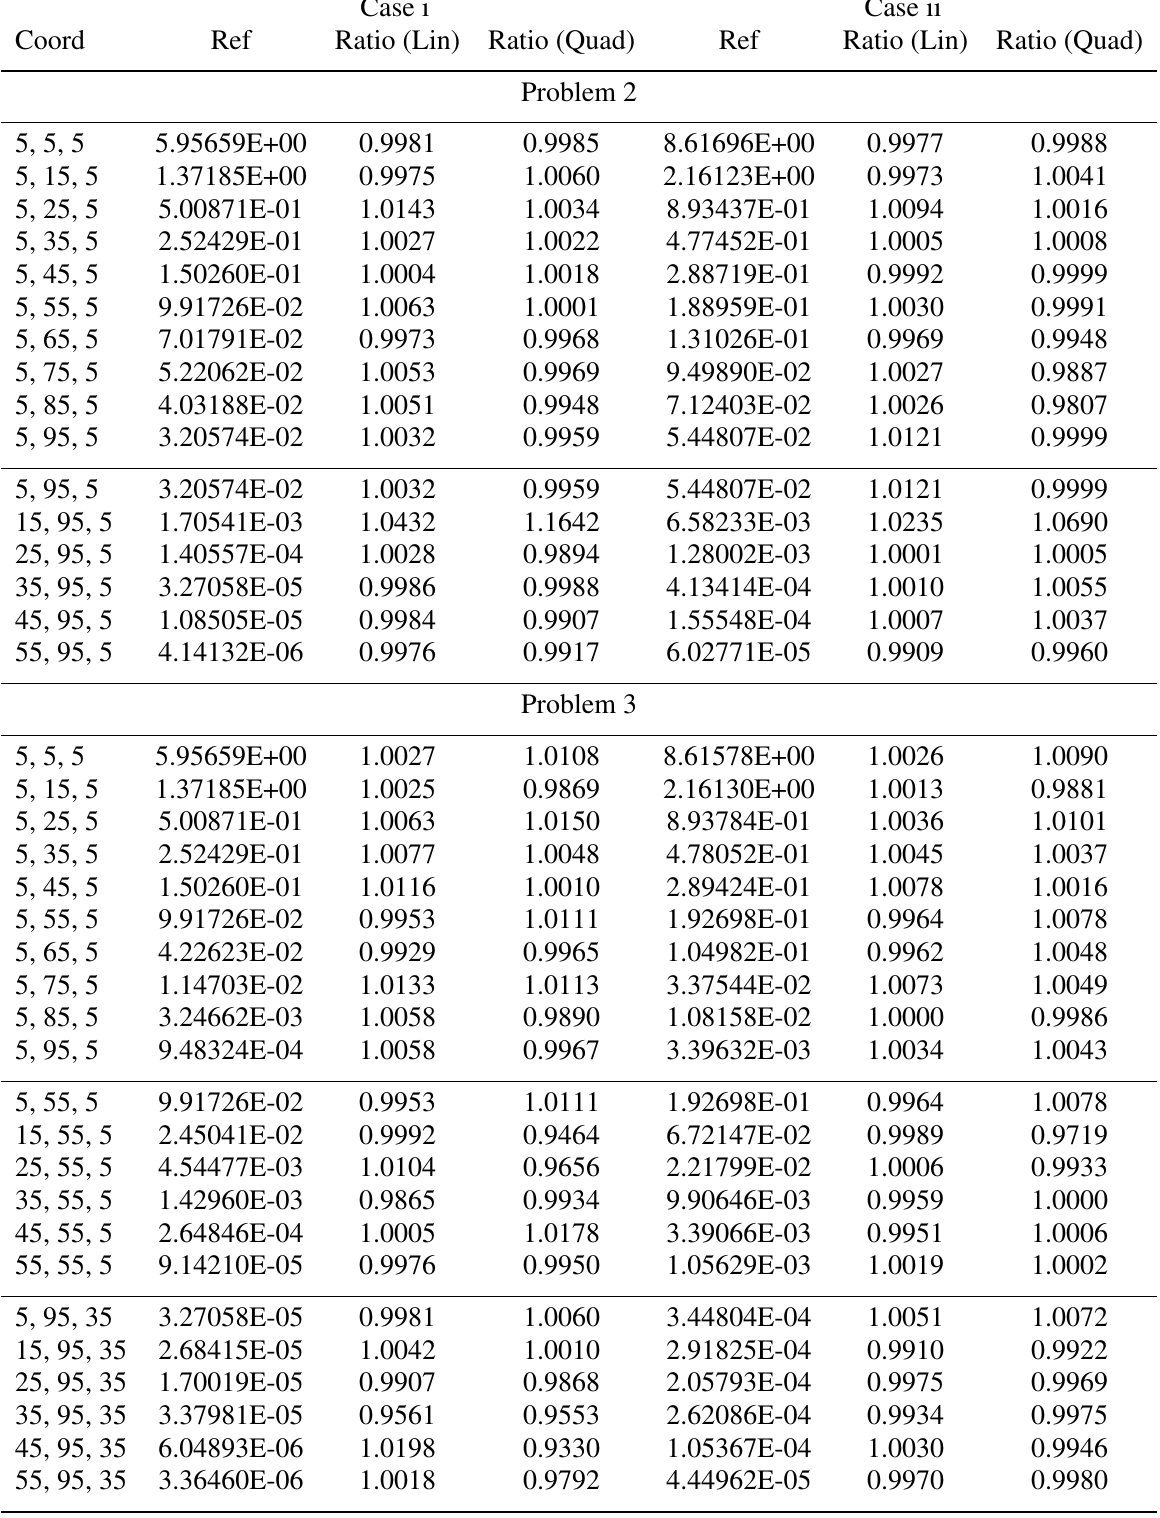
Table 3: Results for Kobayashi problems 2 and